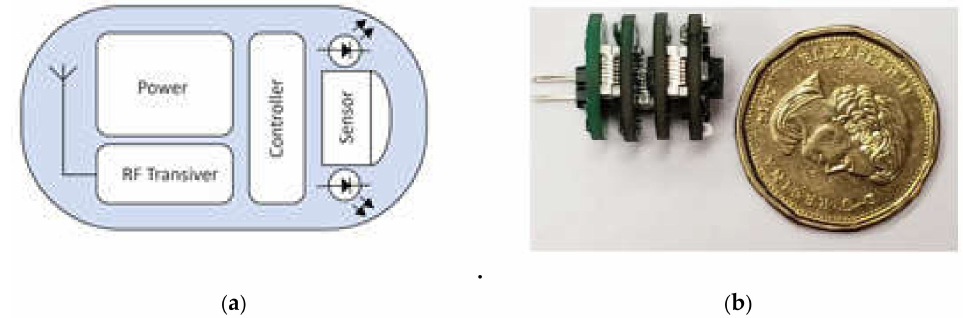
Figure 3. ( a ) Internal components; ( b ) capsule prototype with 4 printed circuit board (PCB) layers (compared with a CAD $1 coin).